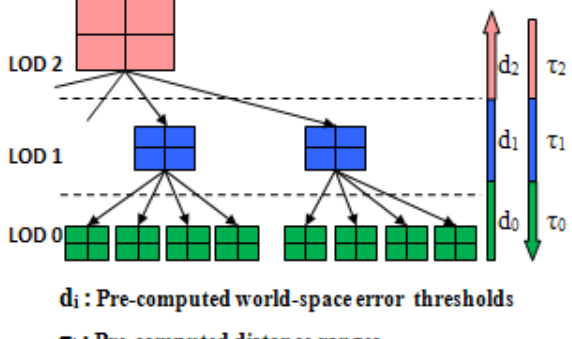
Figure 3. Height-map organized as a Quad-Tree of nodes, and corresponding arrays of distance ranges and elevation tolerable